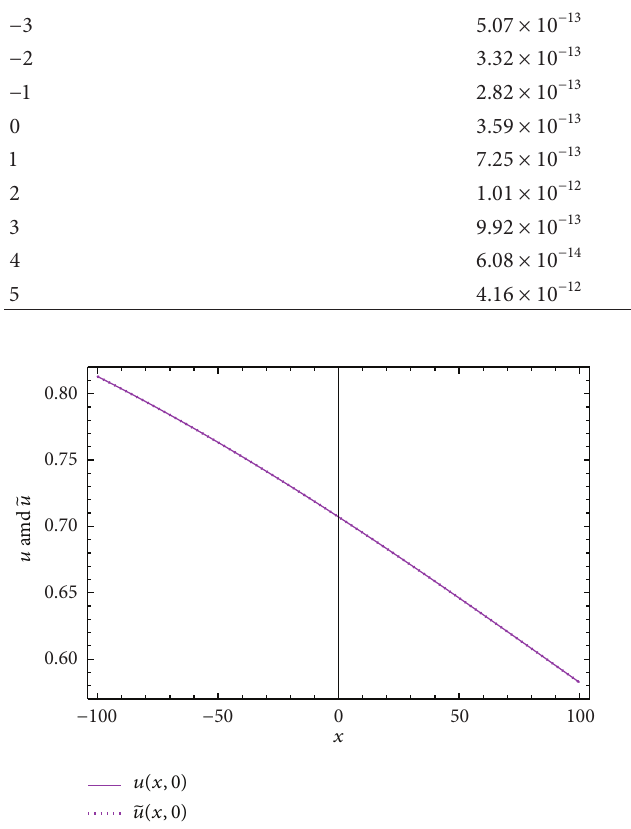
Figure 4: The approximate and the exact solutions for different values of 𝑡 = 0.5 of problem (39) with 𝜃 = 𝜗 = −1/2 , 𝜆 1 = 0.01 , 𝑠 = 2 , and 𝑁 = 12 .